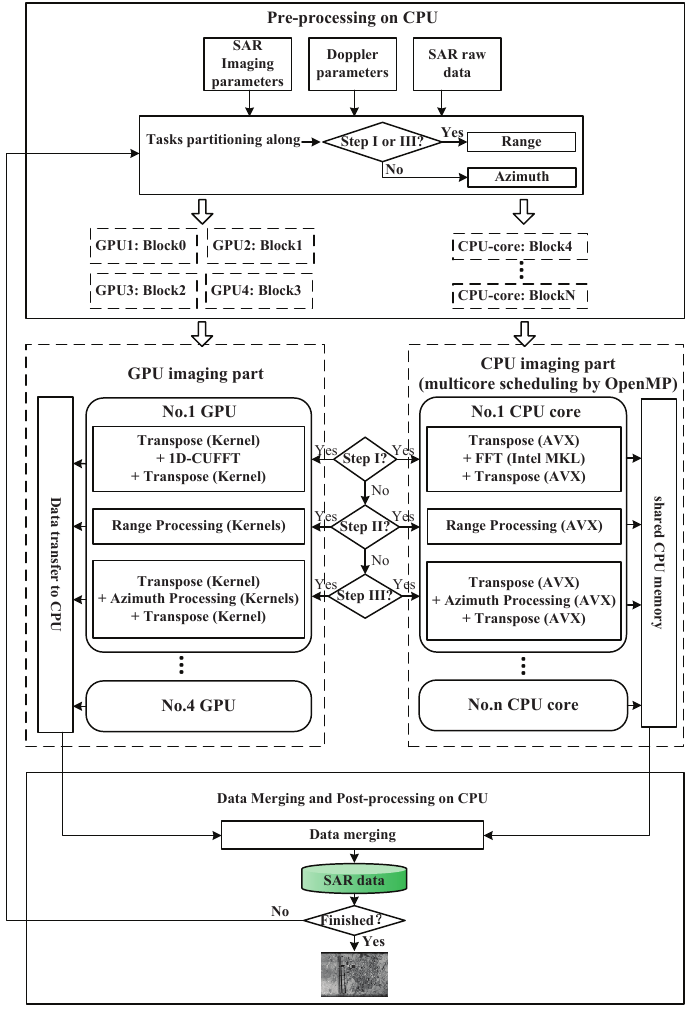
Figure 5. Multiple CPU/GPU deep collaborative imaging